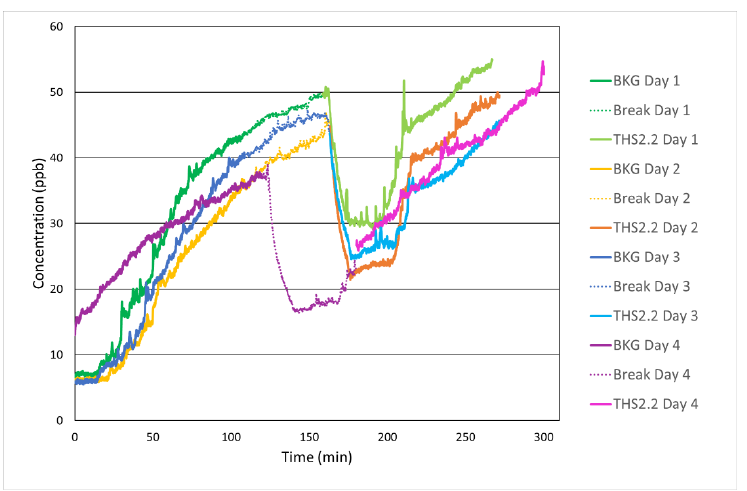
Figure 7. Comparison of NH 3 traces (ppb) during the background (BKG), break, and THS 2.2 sessions (THS) under the simulated Residential category III environment (0.5 h −1 ).